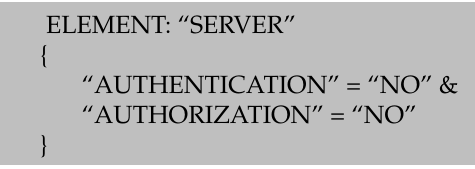
Figure 3. Data Flow Diagram (DFD) ( left ) vs. Extended Data Flow Diagram (EDFD) ( right ).